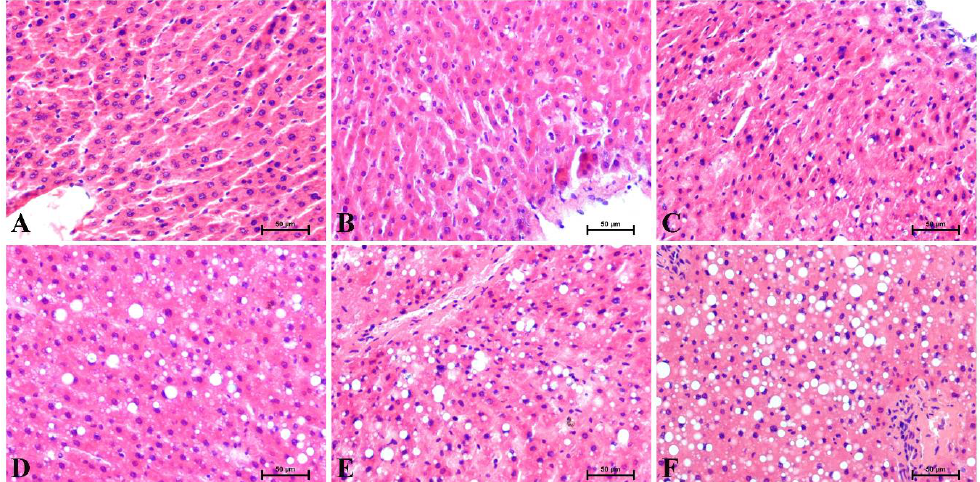
Figure 1. Representative hematoxylin and eosin (H + E) stains of the liver sections at the individual time points from ( A ) 0 week, as the control group, and the experimental HFD weeks: ( B ) 1, ( C ) 2, ( D ) 3, ( E ) 4 and ( F ) 5. The results from each rat ( n = 6) were collected as independent determinations of the specific parts of the liver lobes. 200× magnification. On the lower right, the calibration bar equals 50 μm.